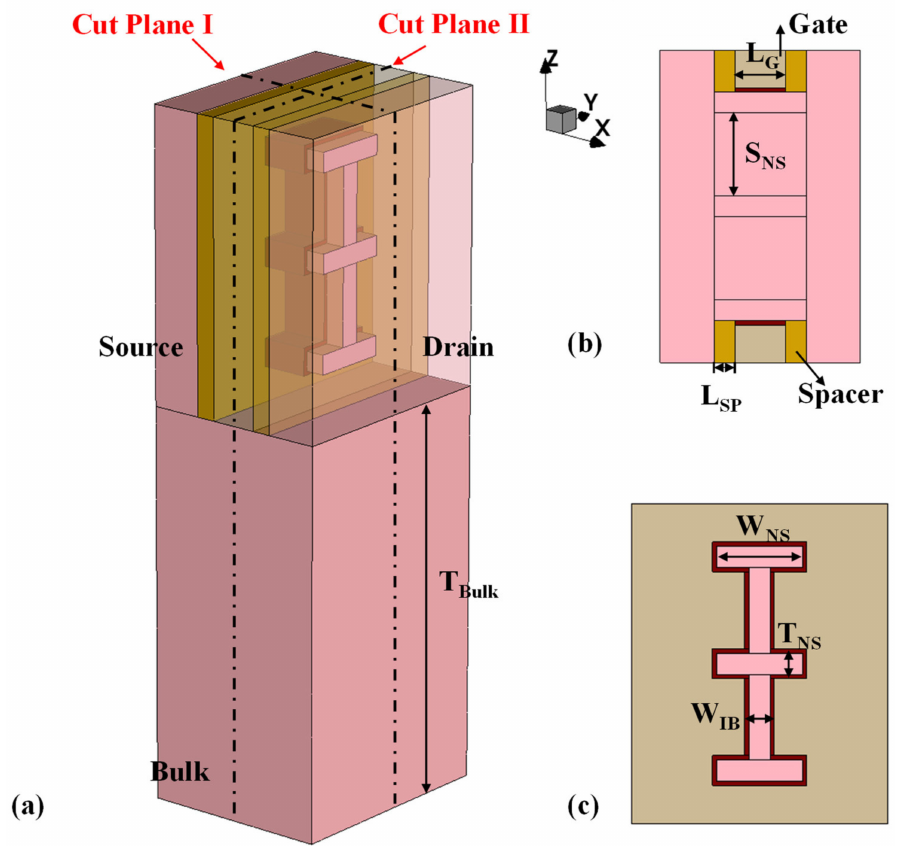
Figure 1. ( a ) Three-dimensional schematic of TreeFET; ( b ) cut plane I cross section along channel length (X-axis); ( c ) cut plane II